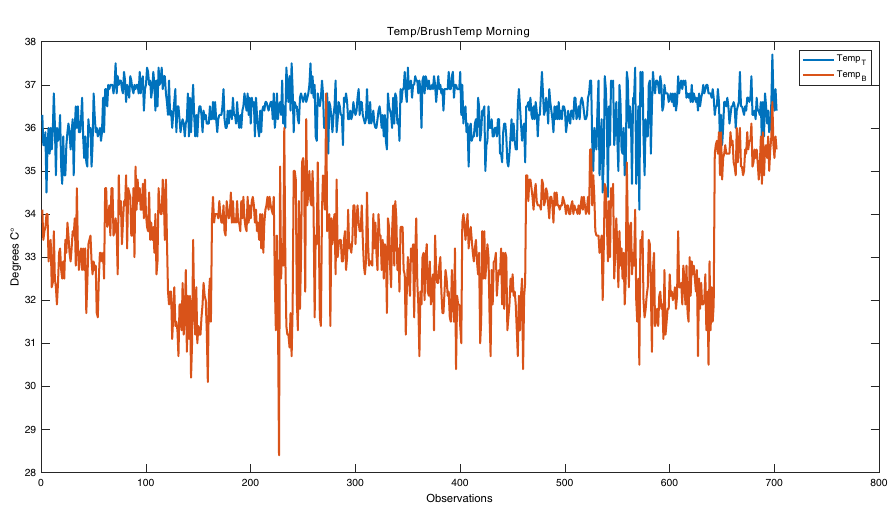
Fig. 5 All measured values T and BT for ID